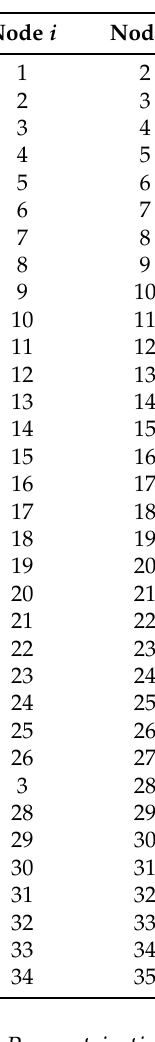
Table 2. Second test feeder, composed of 69 nodes.